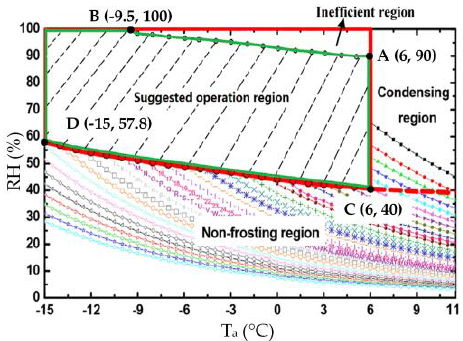
Figure 11. The suggested operation region of the proposed system [73].